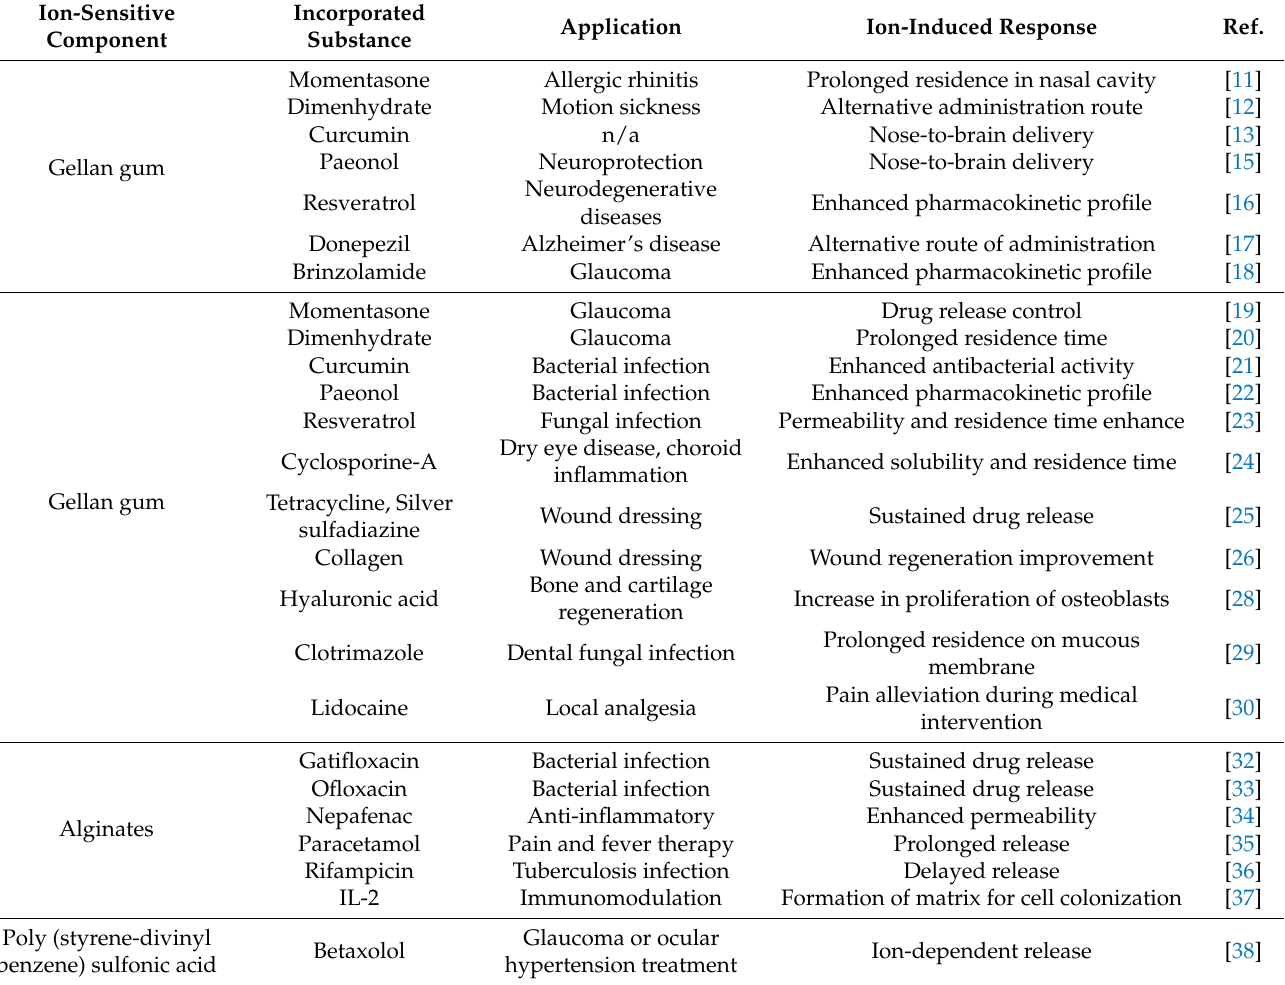
Table 1. Summary of non-selective ion-responsive systems for pharmaceutical applications. Ion-Sensitive Component